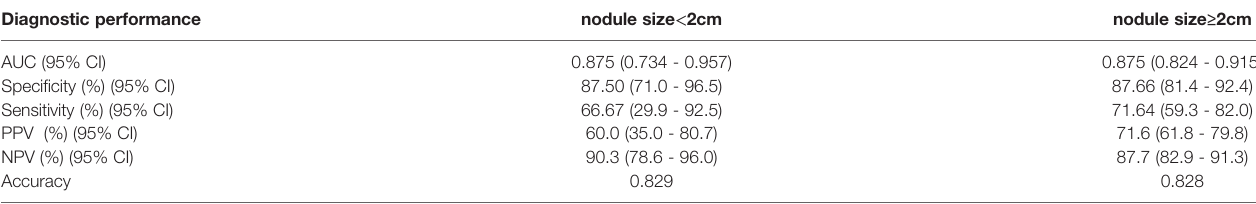
TABLE 4 | Diagnostic performance of the scoring system in nodule size <2cm and ≥ 2cm